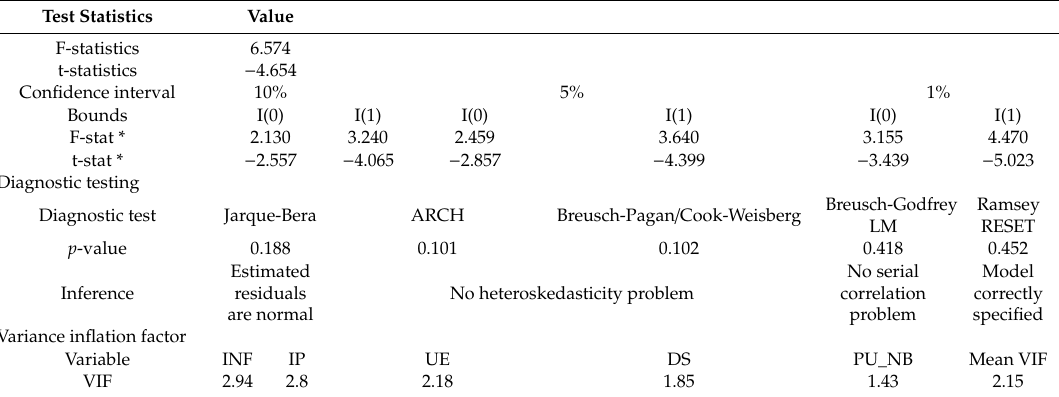
Table 3. ARDL bounds test and diagnostic